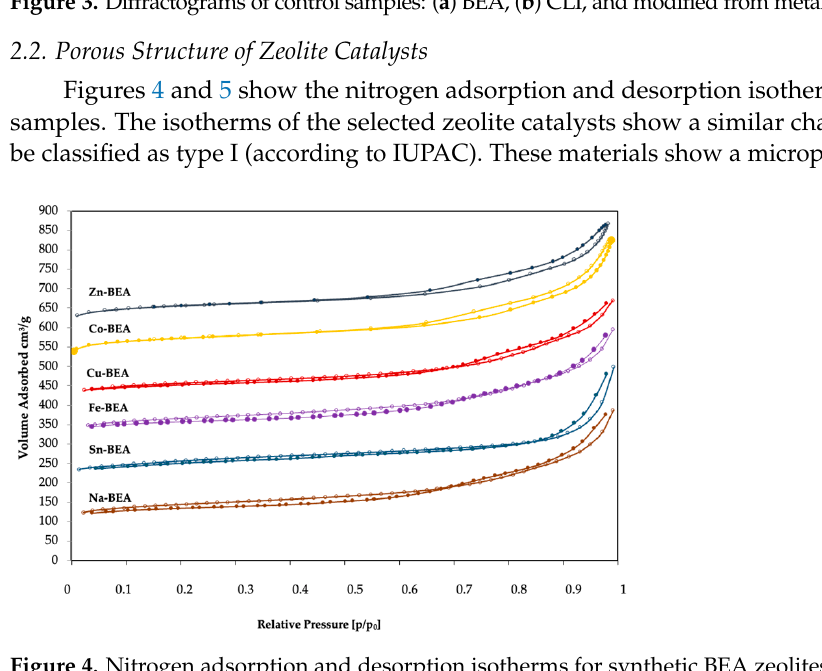
Figure 3. Diffractograms of control samples: ( a ) BEA, ( b ) CLI, and modified from metals (Sn, Fe, Cu, Zn).